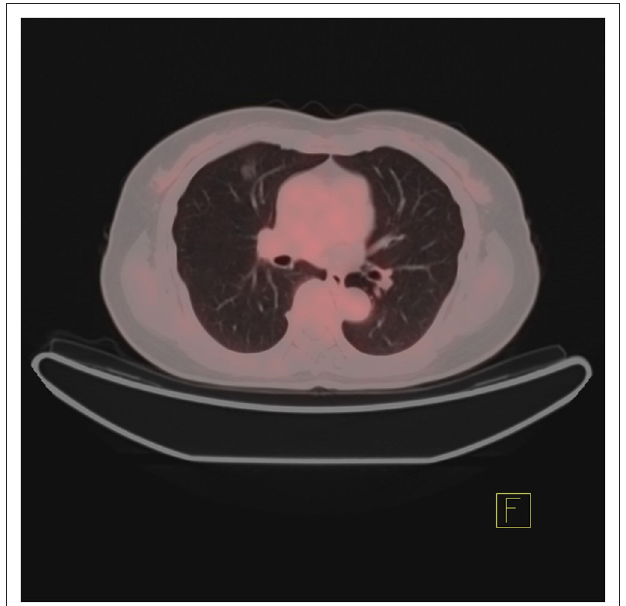
FIGURE 2 | Non-metabolic invasive adenocarcinoma on PET/CT.